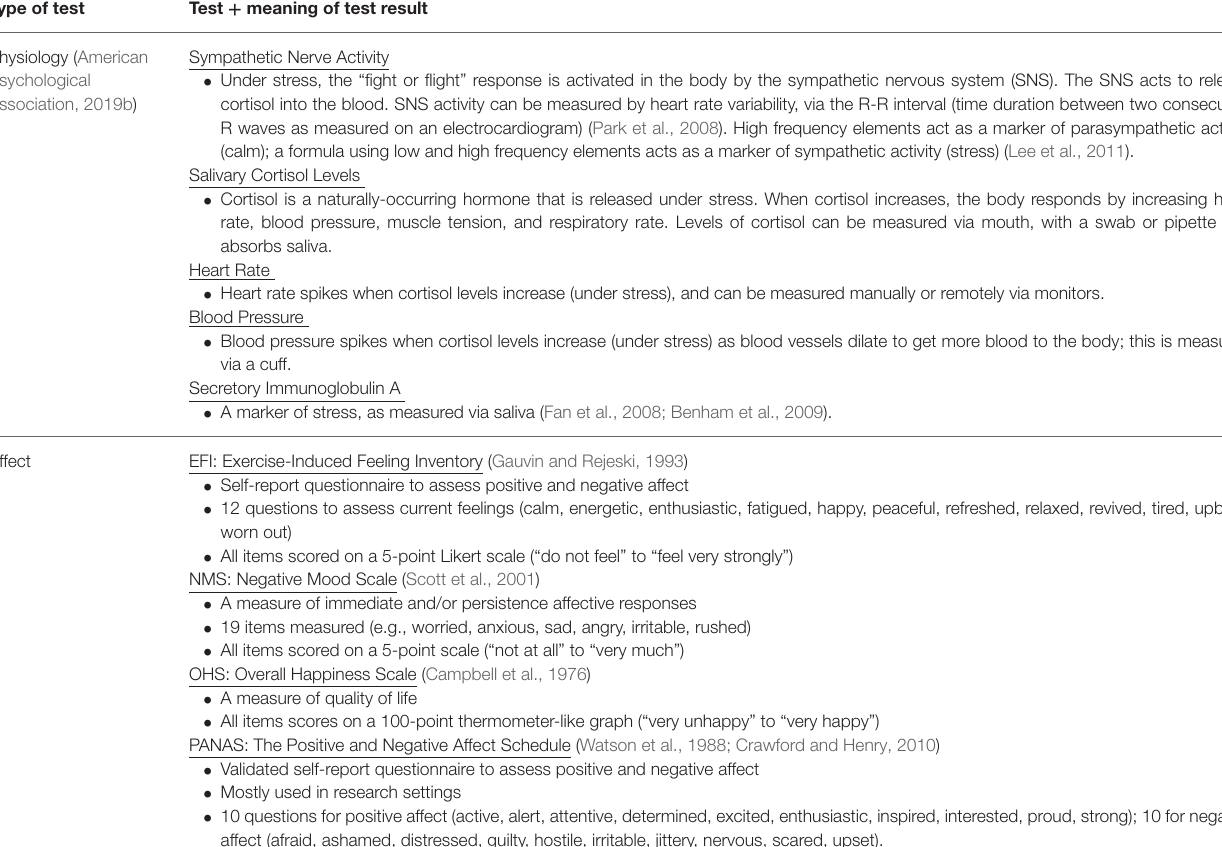
TABLE 2 | Description of measures used in included